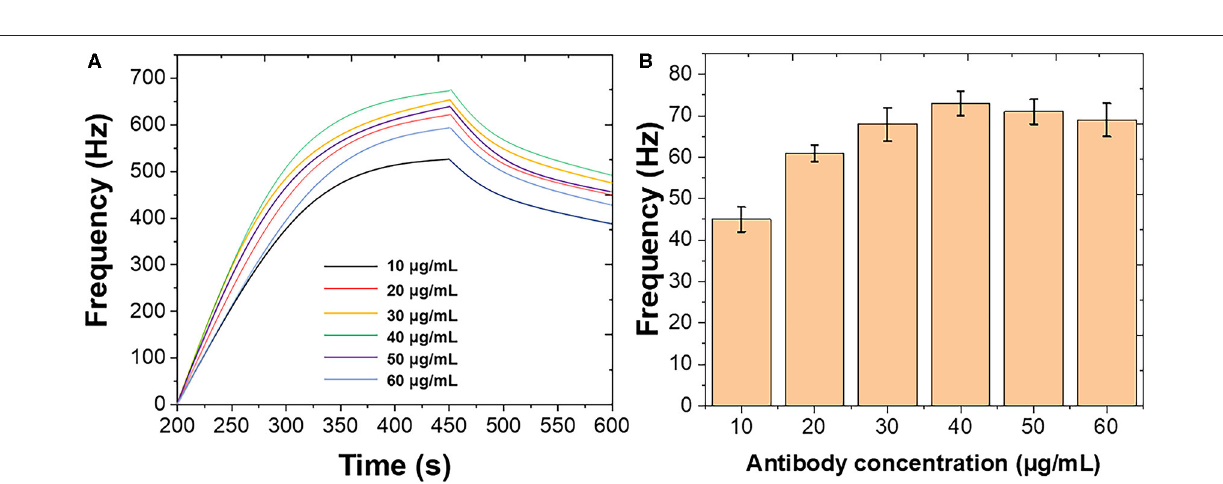
FIGURE 2 | (A) Frequencies recorded at QCM when different concentrations of mouse monoclonal antibody immobilized on the Au chip surface. (B) Frequencies performance of QCM after introduction of B. bifidum after the immobilization of different concentrations of mouse monoclonal antibody.